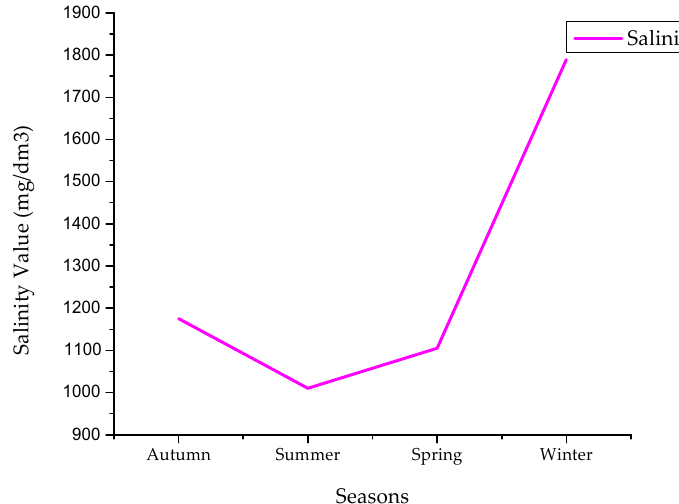
Figure 8. Concentration values for salinity from images during four seasons of 2017.